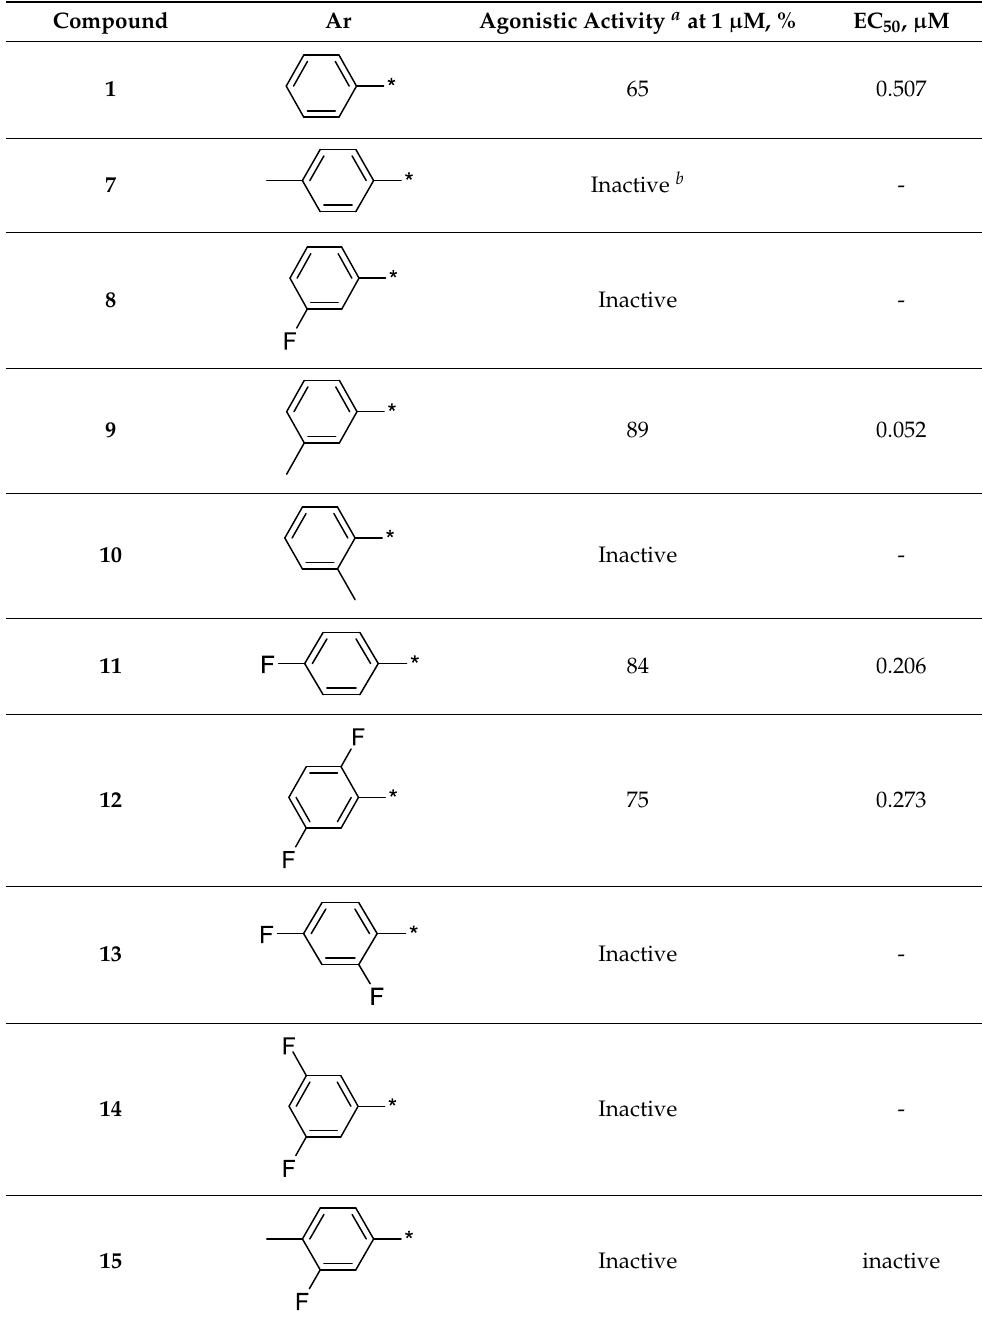
Table 1. Agonistic activity of compounds 7 – 30 with respect to TAAR1.